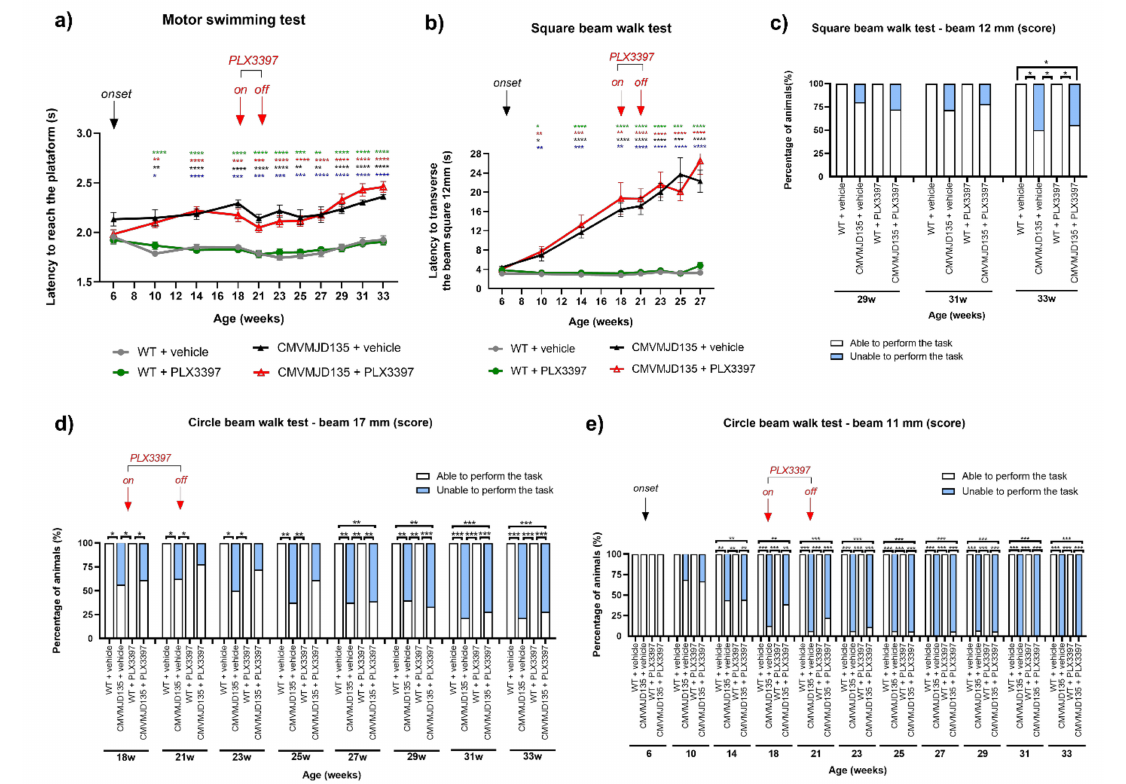
Figure 6. PLX3397 treatment had no impact on the motor coordination and balance deficits of CMVMJD135 mice. ( a ) Motor swimming test showed that CMVMJD135 mice (PLX3397- and vehicle- treated) spent more time swimming than WT mice (PLX3397- and vehicle-treated), throughout age. No significant differences were found between PLX3397-treated and vehicle-treated mice (curve comparison over time p > 0.05, 6–33 weeks). One-way ANOVA (post hoc Dunnett T3 test). ( b ) In the square beam test, no differences were found between CMVMJD135 + PLX3397 and CMVMJD135 + vehicle mice, and between WT + PLX3397 and WT + vehicle mice (curve comparison over time p > 0.05, 6–27weeks). One-way ANOVA (post hoc Dunnett T3 test). In both motor swimming and square beam tests, asterisks indicate significant differences which were found between: * WT + vehicle and CMVMJD135 + vehicle; * WT + vehicle and CMVMJD135 + PLX3397; * WT + PLX3397 and CMVMJD135 + vehicle; and * WT + PLX3397 and CMVMJD135 + PLX3397. The 12 mm-square beams walk test (at 29, 31, and 33 weeks of age) and the 17 mm-round beams walk test (from 18 weeks of age onwards), were analyzed by scoring the animals. ( c ) In the square beam (score) and ( d ) in the circle beam of 17 mm-round (score), significant differences were found between CMVMJD135 + vehicle mice and WT + vehicle mice, but no differences were found between CMVMJD135 + PLX3397 and CMVMJD135 + vehicle mice, and between WT + PLX3397 and WT + vehicle mice. Friedman test with Kruskal–Wallis analysis. ( e ) In the circle beam of 11 mm-round (score), results showed significant differences between WT + vehicle and CMVMJD135 + vehicle, but not between PLX3397-treated and vehicle-treated mice, from 14 weeks to 33 weeks of age. Friedman test with Kruskal–Wallis analysis. Values are presented as mean ± SEM or as percentage of animals (%) (for the continuous and non-continuous variables, respectively). Means were considered statistically significant at a p -value * p < 0.05, ** p < 0.01, *** p < 0.001, **** p < 0.0001. Difficulties in traversing the 11 mm-round beam were observed in CMVMJD135 + vehicle mice from 14 weeks of age onwards when compared with WT + vehicle